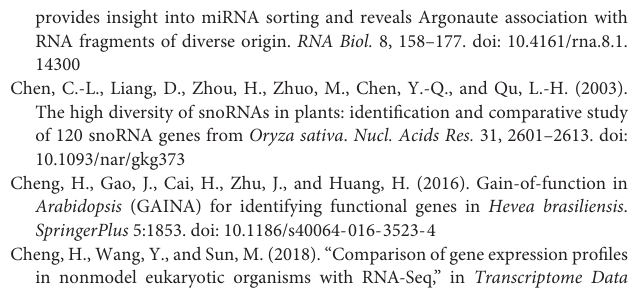
Supplementary Figure 1 | Predicted modification sites in 5.8S, 18S, and 28S rRNA sequences in Hevea brasiliensis . Supplementary Figure 2 | Spearman correlation coefficient between the expression of 10 laticifer-abundant small nucleolar ribonucleic acids (snoRNAs) and the total latex production and total solid content (TSC)/C ( R 2 = 0.2–0.4). Supplementary Table 1 | Sequences analysis of snoRNA libraries by high-throughput sequencing. Supplementary Table 2 | Putative snoRNA candidates in rubber tree. Supplementary Table 3 | Spearman correlation coefficient between the expression of 31 laticifer-abundant snoRNAs and the total latex production and